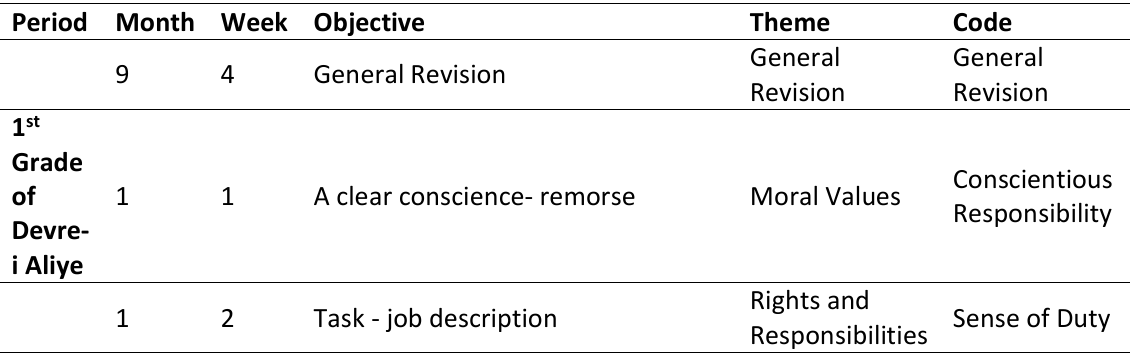
Table 3. Objectives, Themes and Values of Devre-i Aliye 1 st and 2 nd Grades in the 1913 Curriculum of Musâhabât-ı Ahlâkiyye [Conversations on Morality]